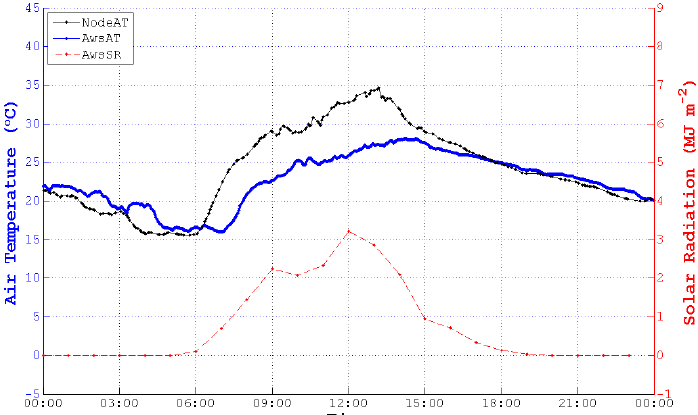
Figure 7. Raw data of NodeAT, AwsAT and AwsSR sensed directly by sensors on 13 May 2014.